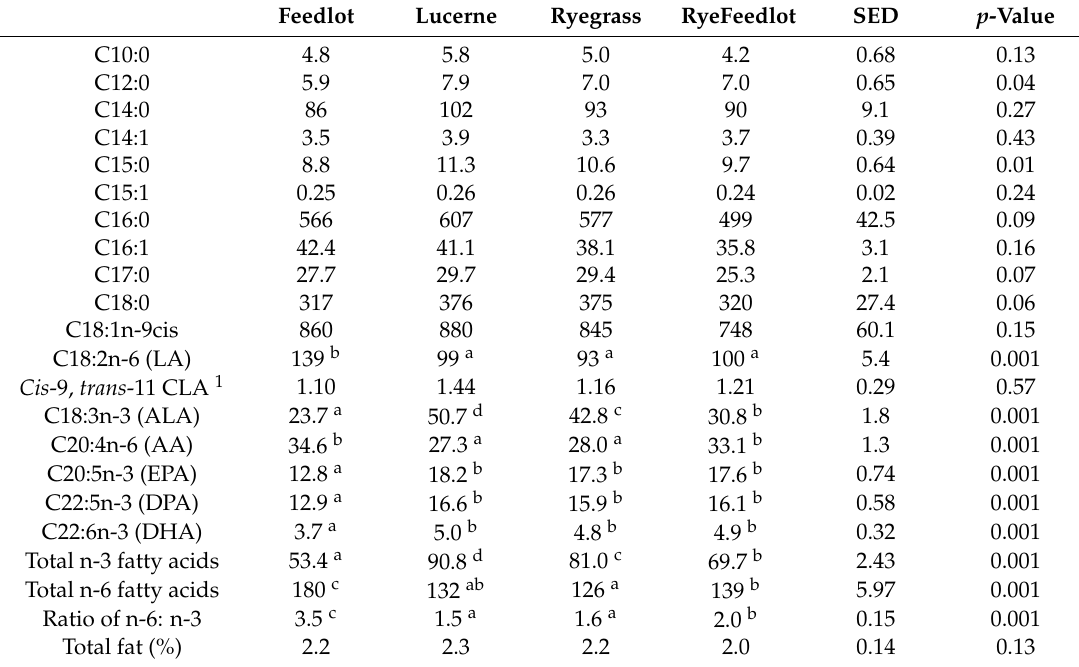
Table 3. Individual fatty acid composition and total fat content (mg/100 g of muscle) of longissimus lumborum muscle from lambs consuming feedlot or grazing lucerne (alfalfa) pasture, ryegrass pasture or ryegrass pasture plus feedlot (RyeFeedlot).